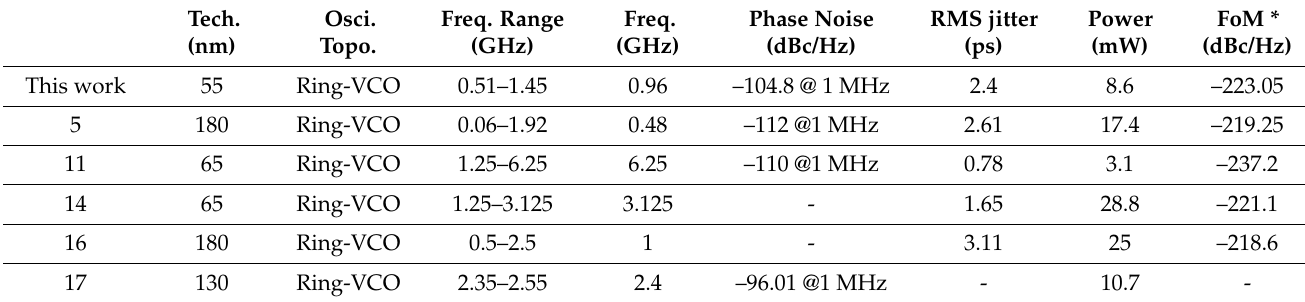
Figure 16. Measured phase noise of the proposed PLL. Table 1. Performance summary and comparison.